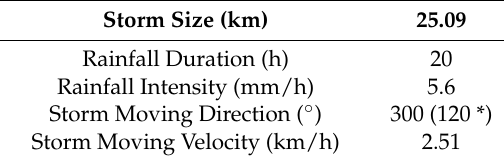
Table 3. Parameter setup for the synthetic moving storm